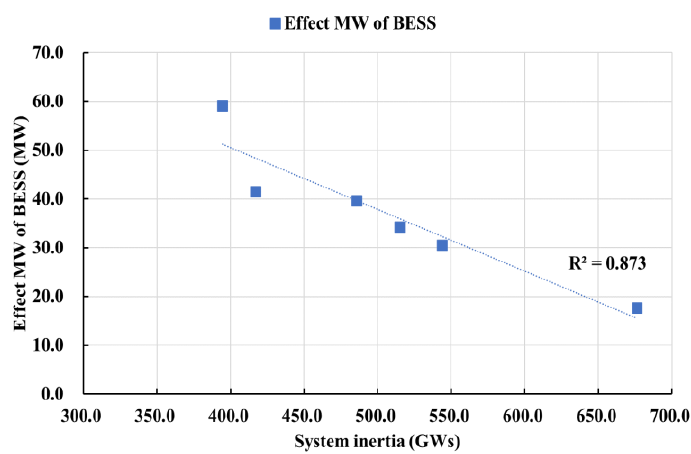
Figure 11. Analysis of BESS Effect MW according to System Inertia.